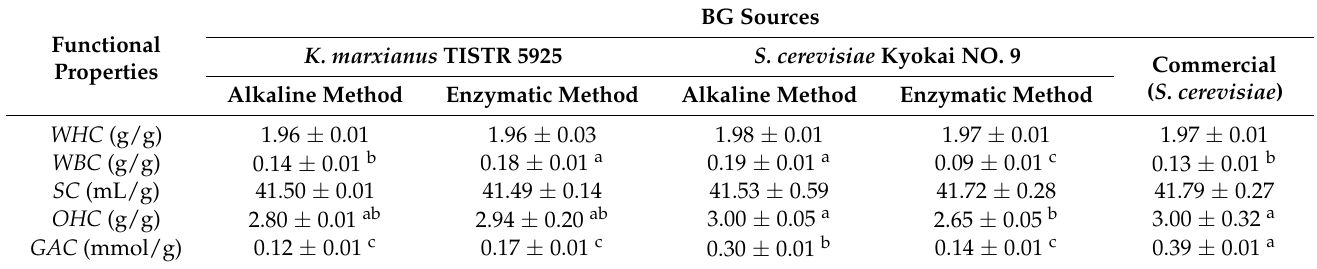
Table 3. Water-holding capacity ( WHC ), water-binding capacity ( WBC ), swelling capacity ( SC ), oil-holding capacity ( OHC ), and glucose adsorption capacity ( GAC ) of K. marxianus TISTR 5925, S. cerevisiae Kyokai NO. 9, and commercially available